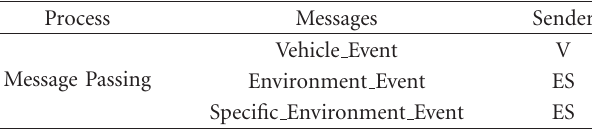
Table 3: Vehicle-Vehicle/Environment Server